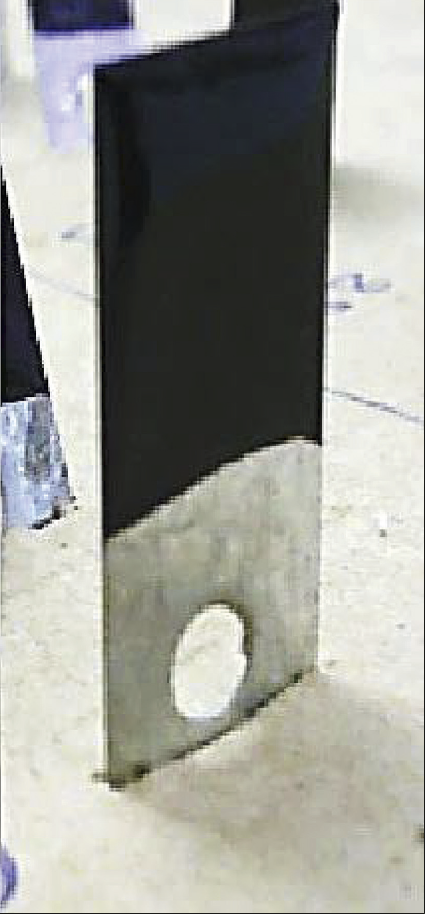
Figure 3: Metallic strip coated with